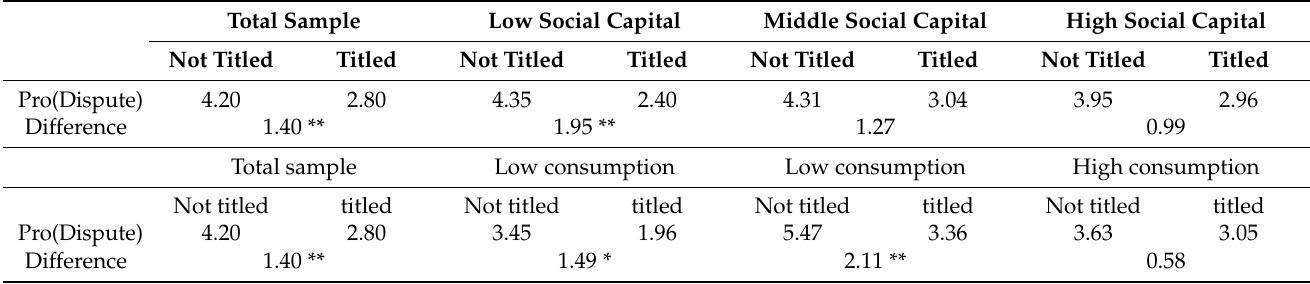
Table 2. T test of the dispute probability between groups with and without